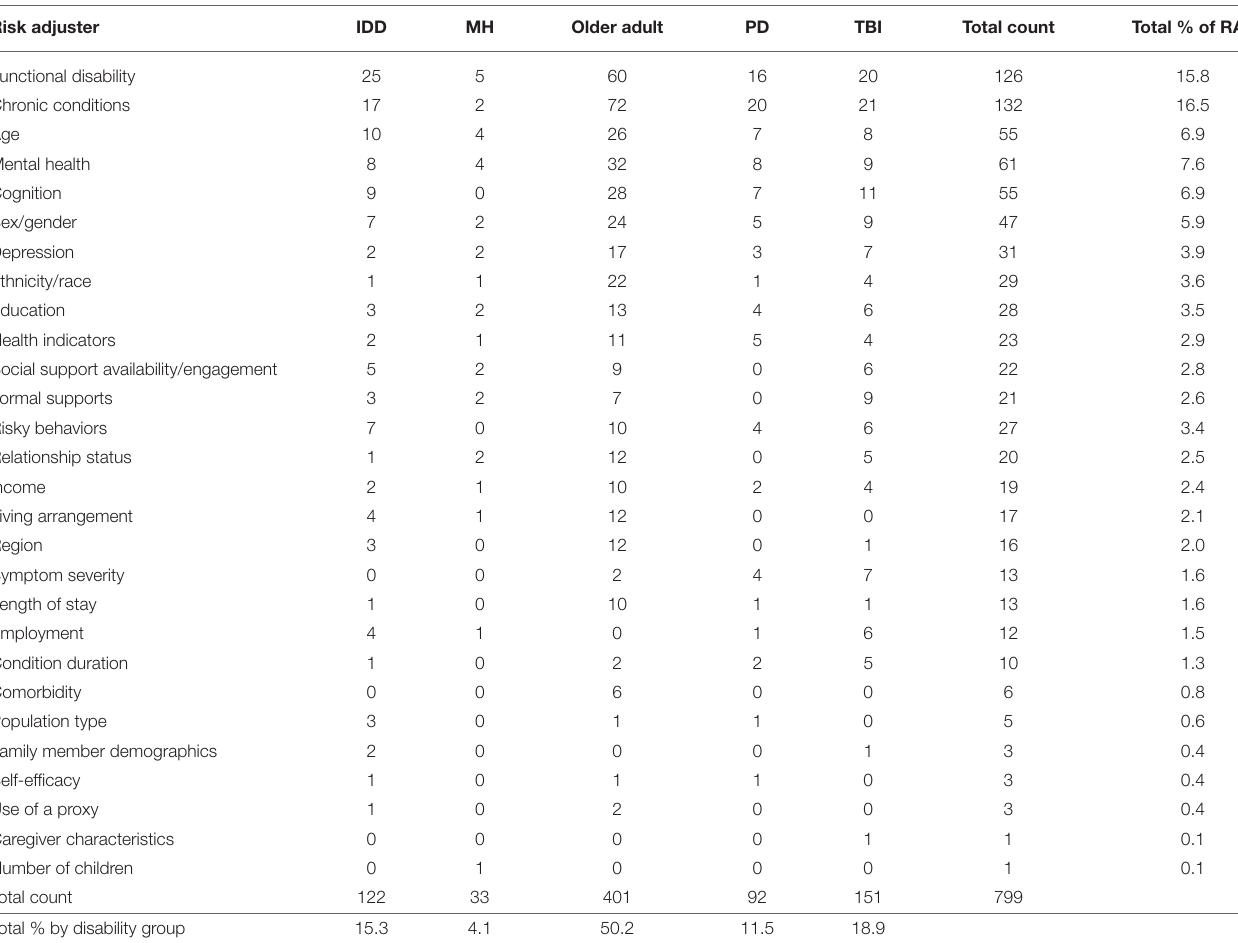
TABLE 3 | Individual-level risk adjusters by population